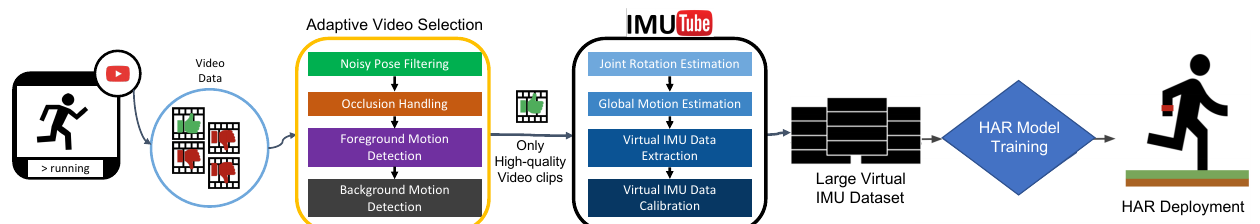
Figure 1. Deriving human activity recognition systems from large scale virtual IMU data generated through IMUTube [14]. Videos for specific activities are retrieved from public repositories such as YouTube through keyword-based queries. These search terms serve as weak labels for all generated sensor data. The IMUTube system then processes the retrieved videos to (i) suppress irrelevant videos; (ii) eliminate portions of the videos that are of insufficient quality (motion blur, occlusions, etc.); (iii) generates virtual IMU data for on-body sensor positions as specified by the query; and (iv) calibrates the virtual IMU data towards more realistic sensor data. The resulting, large-scale virtual IMU dataset is then used for HAR model